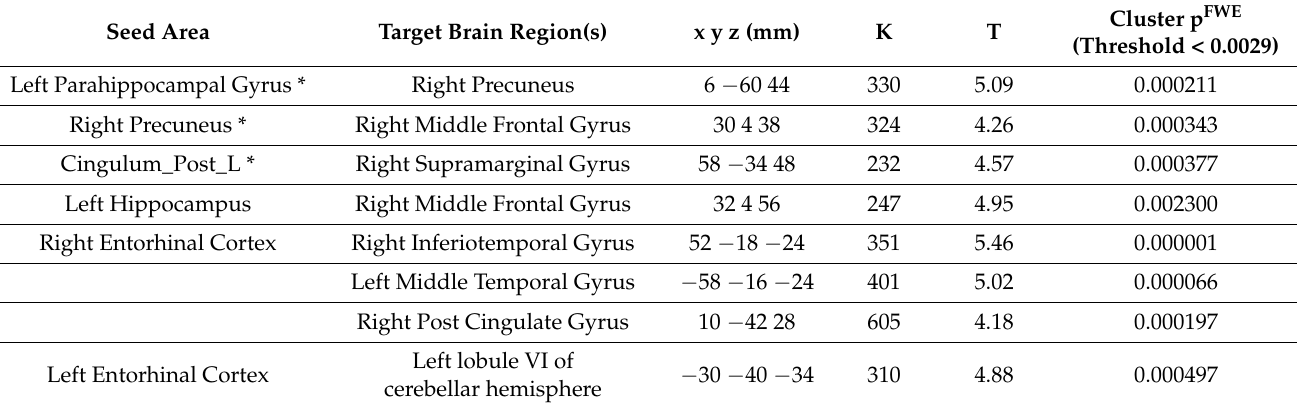
Table 1. Spatial learning related changes in resting state FC on Day 1 (rsfMRI 2 > rsfMRI